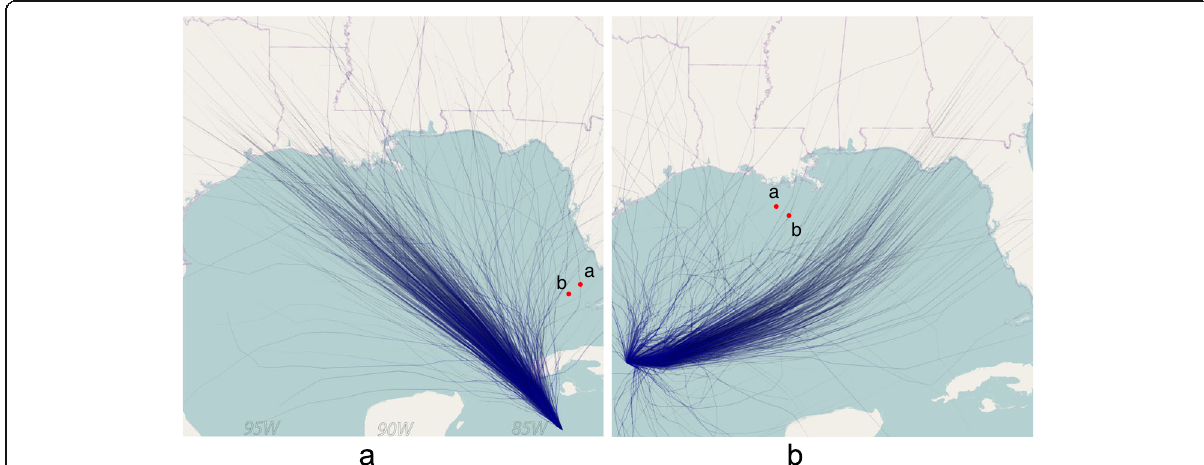
Fig. 8 Examples of the stimuli used in Experiment 2 depicting two hurricanes. a Condition in which the farther rig from the center of the storm was located on a hurricane track. b Condition where the closest rig was located on a hurricane